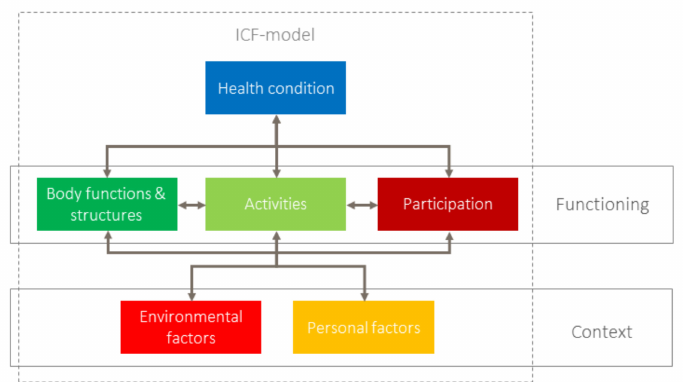
Figure 1. International Classification of Functioning, Health and Disability (ICF) model